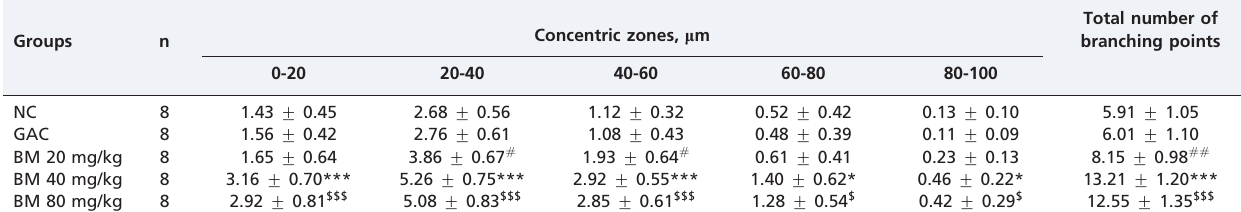
Table 4 - Basolateral amygdaloid neuronal dendritic branching points at different concentric zones and total number of branching points (6-week